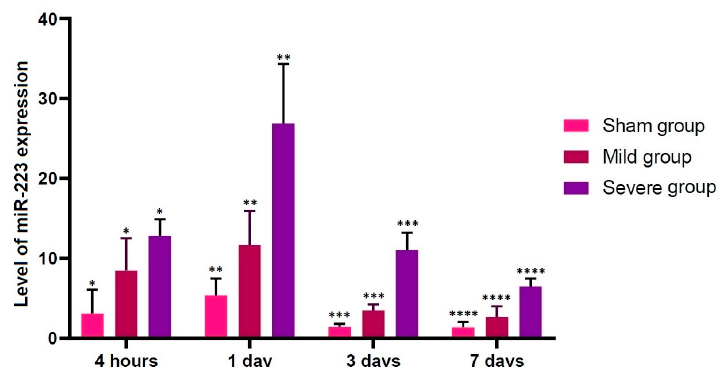
Figure 5. Up-regulation of miR-223. There were significant alterations in the level of miR-223 expression at all time points studied through all the experimental groups ( P < 0.05). Asterisks indicate significant differences between the same ones at P < 0.05.